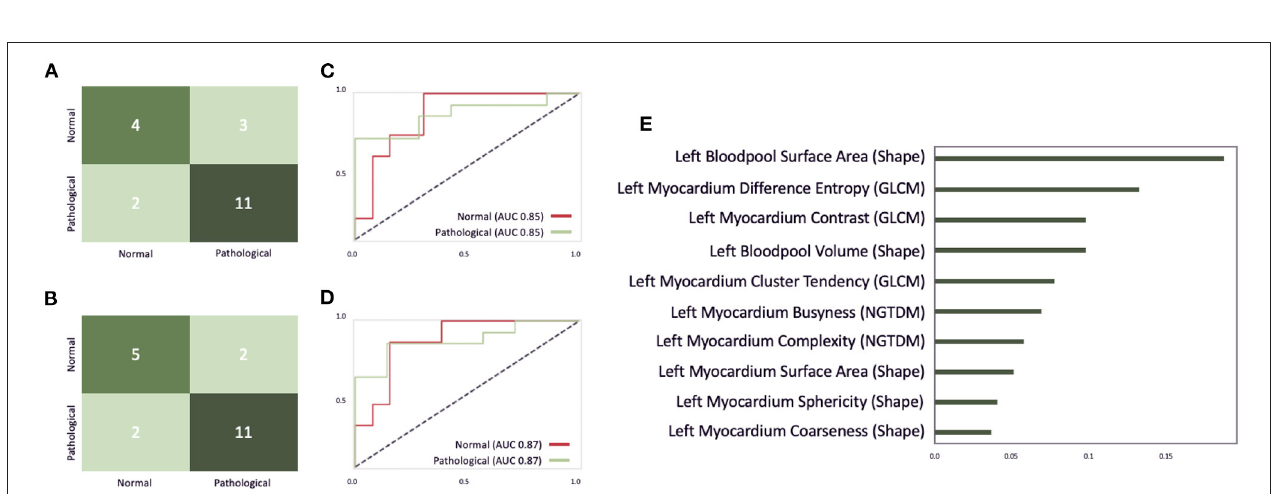
FIGURE 10 | Illustration of the ACDC classifier performance on the test dataset consisting of 20 cases. (A,B) Highlights the confusion matrix for the ACDC classifier before and after the correction of image segmentations via our described visual outlier detection. Similarly, (C,D) show the AUC score improvement of the classifier. (E) Depicts the 10 most important features for this classifier.